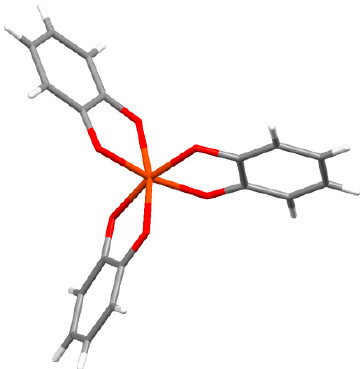
Figure 1. Coordination geometry of the tris(catecholato)Fe(III) complex from the crystal structure of piperidinium tris(pyrocatecholato)ferrate(II) sesquihydrate [45] .